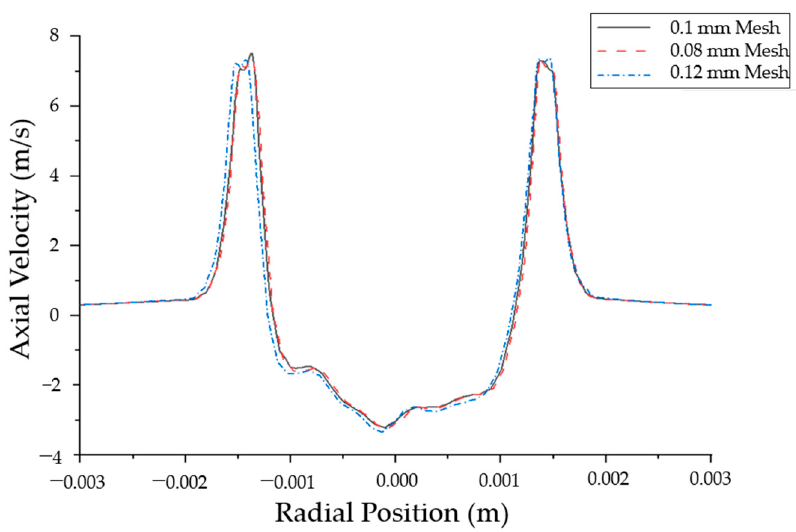
Figure 4. Comparison of the axial velocity distribution of the spray field 3 mm away from the inlet with different initial mesh sizes at 20 °C.